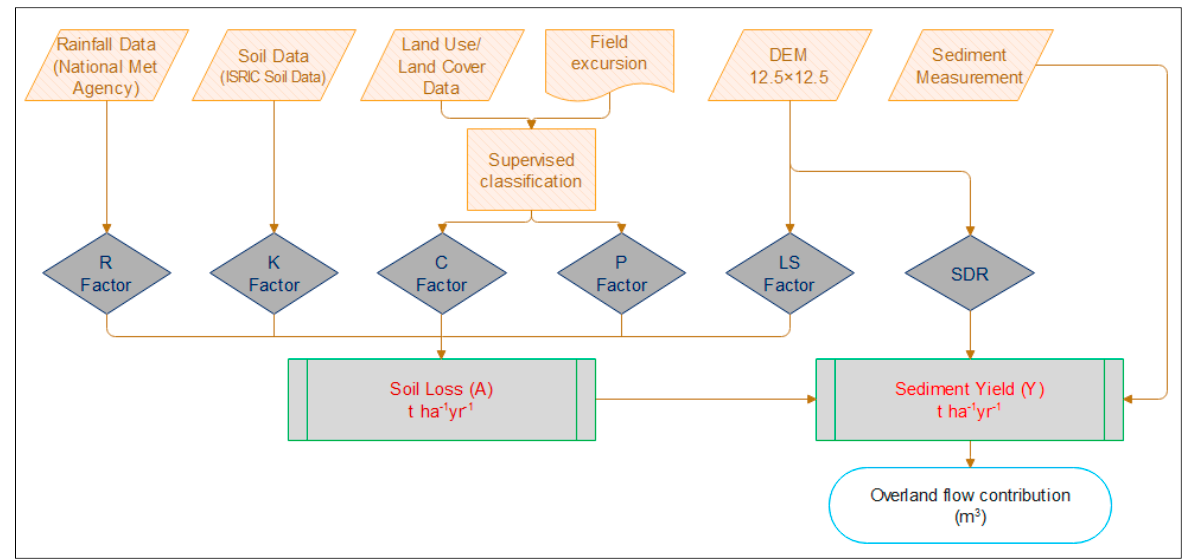
Figure 3. Conceptual framework for quantifying soil loss and sediment yield in the canals of the irrigation schemes from overland flow sources.